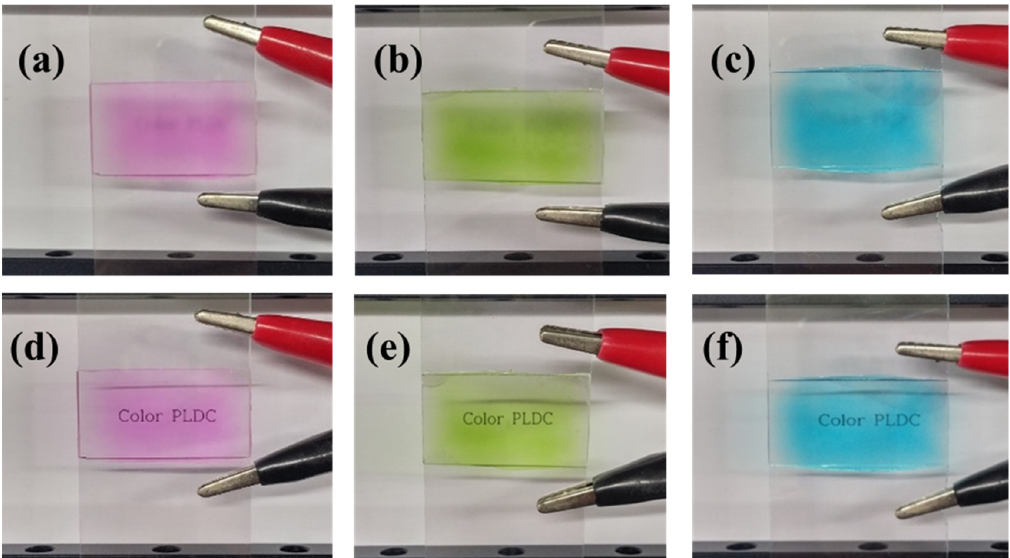
Figure 6. Electro-optical effects of our color PDLC device. The scattering states of ( a ) the red PDLC device, ( b ) green PDLC device, and ( c ) blue PDLC device without a voltage being applied. The transparent states of ( d ) the red PDLC device, ( e ) green PDLC device, and ( f ) blue PDLC device with a voltage being applied.